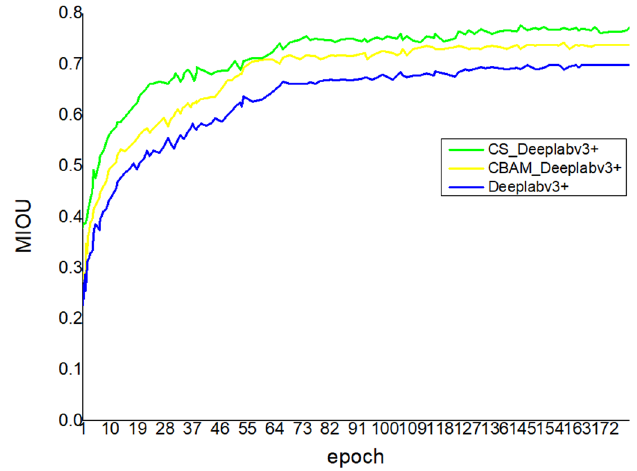
Figure 7. MIOU result curves for different networks.